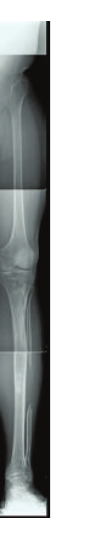
Figure 5: Radiograph of entire lower limbs at 5 years after leg